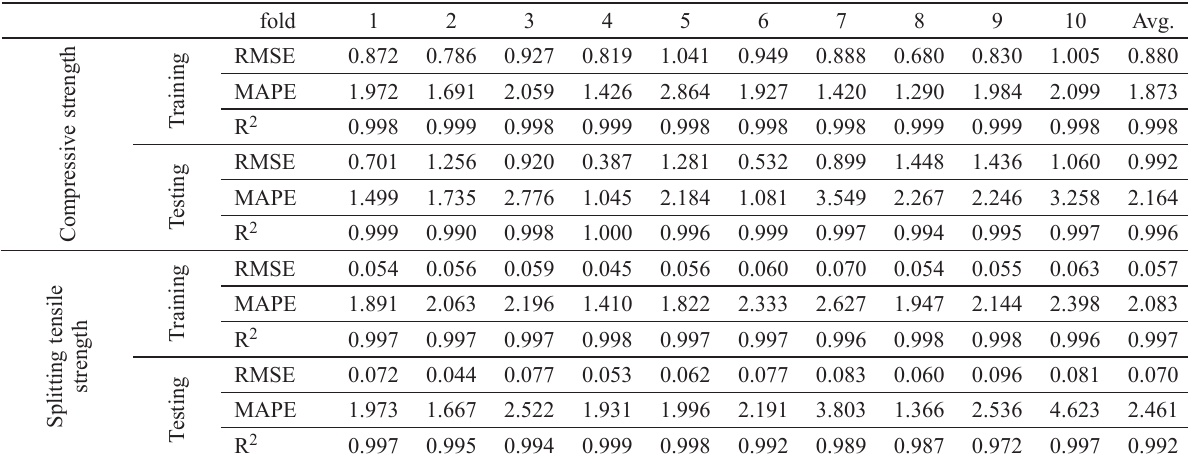
Table 2. EMARS testing and training results